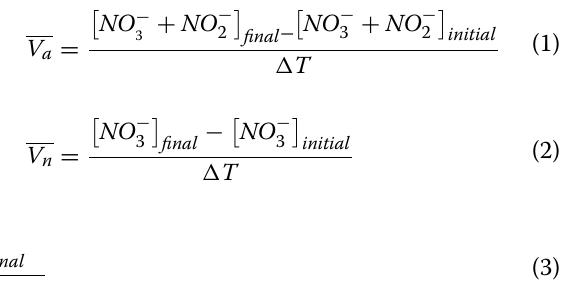
The average and instantaneous data parameters (including maximum instantaneous data points) were suggested in Fig. 2. The three indices (V a , V n and their maximum value) described the average nitrification potential and maximum nitrification potential of a sample. The dynamic process of nitrification in samples was depicted in Fig. 1. The index of nitrogen balance (INB) was used to make an estimation with the total amount of variability of DIN in the incubation system (Eq. (3)).